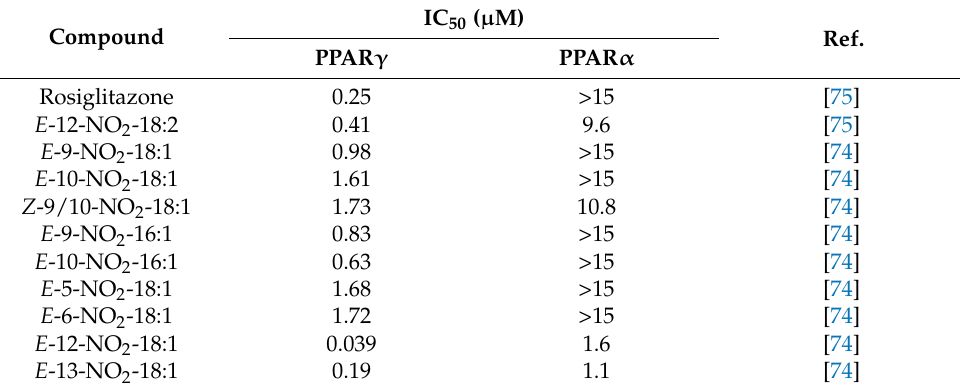
Table 1. NO 2 -FA-PPAR SAR study. E -12-NO 2 -18:1 exhibits the highest activity as PPAR γ